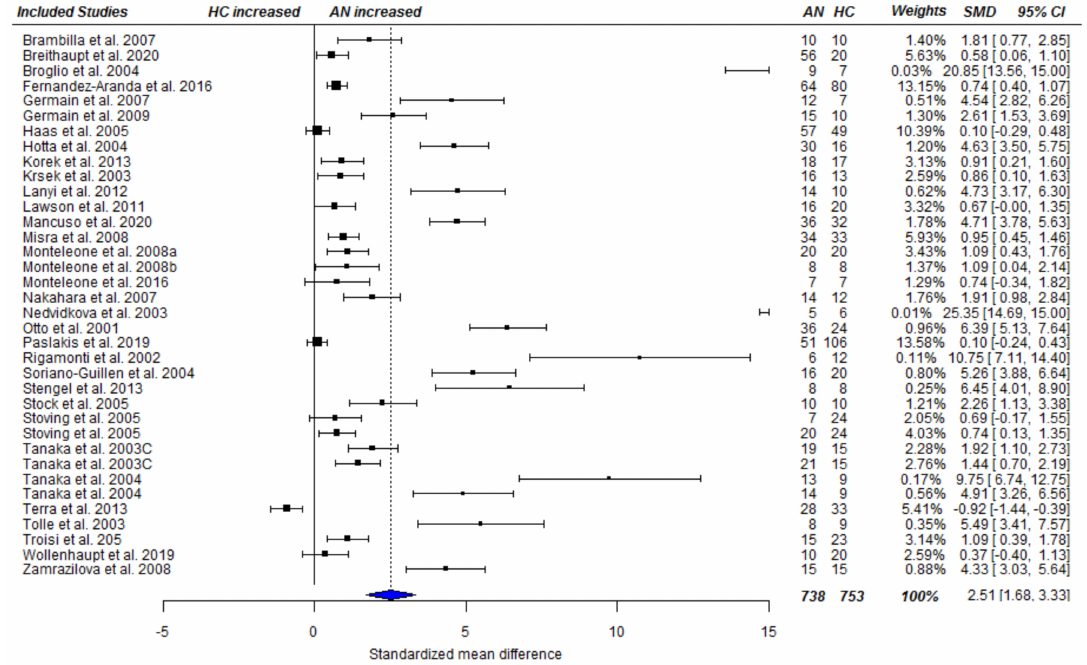
Figure 2. Forest plot of cross-sectional comparison of AN patients at baseline (pre-treatment; T1) and HCs on total ghrelin. AN = anorexia nervosa; HC = healthy control; SMD = standardized mean difference, CI = confidence interval. Studies listed more than once reported separate values for AN subtypes.